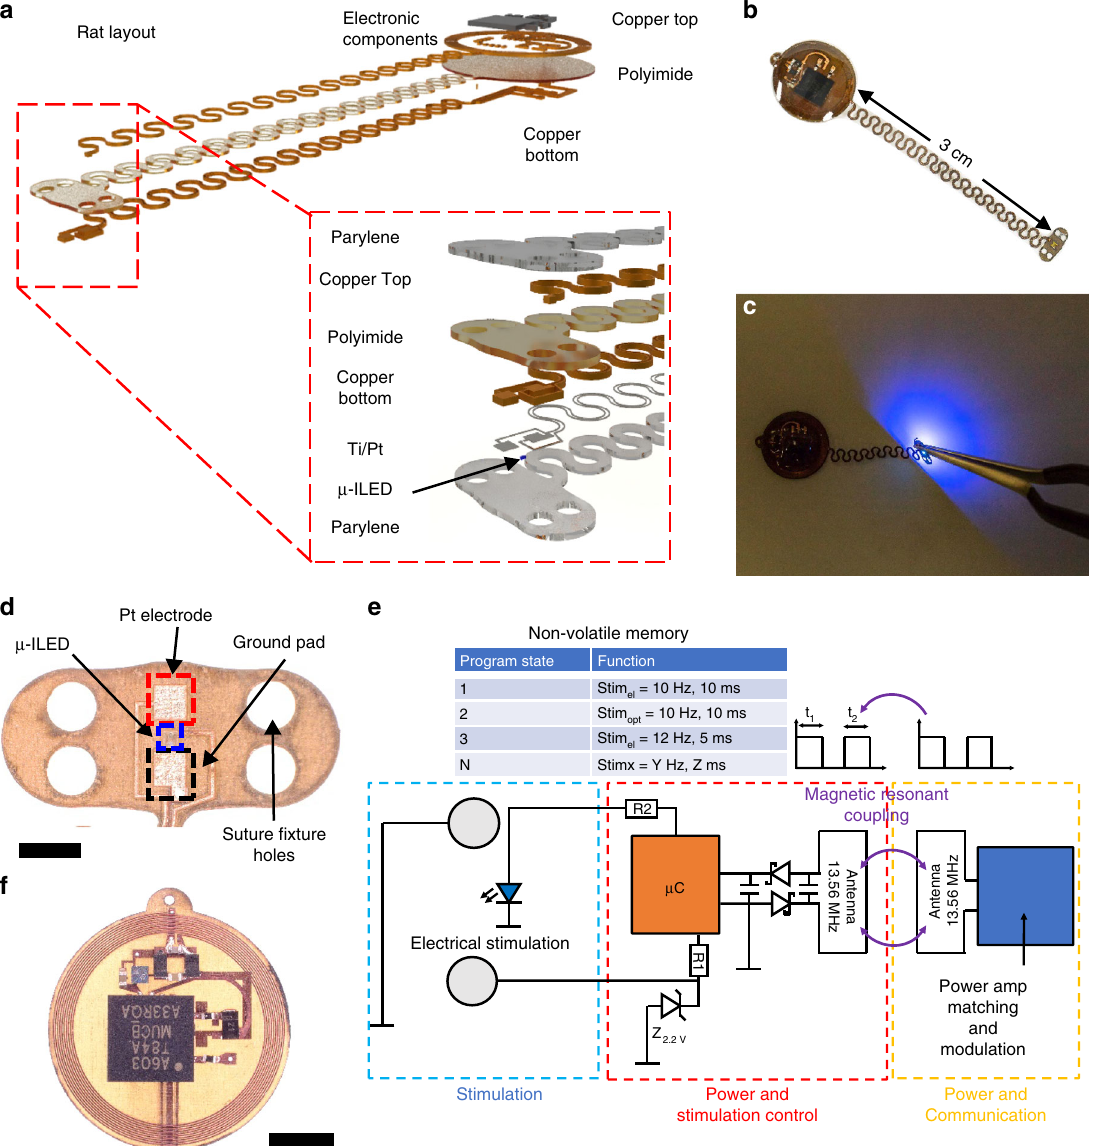
Fig. 1 Wireless, battery-free, fully implantable pacemakers with electrical and optical stimulation capabilities. a Rendered images of the layered designs of devices con fi gured for rats and mice. b Photographic images of the devices. c Photographic image of device activated for optogenetic stimulation capability. d Optical micrograph of the stimulation electrode (scale bar 1 mm). e Schematic illustration of the operating principles. f Microscopic image of the receiver and control unit of the device (scale bar 3